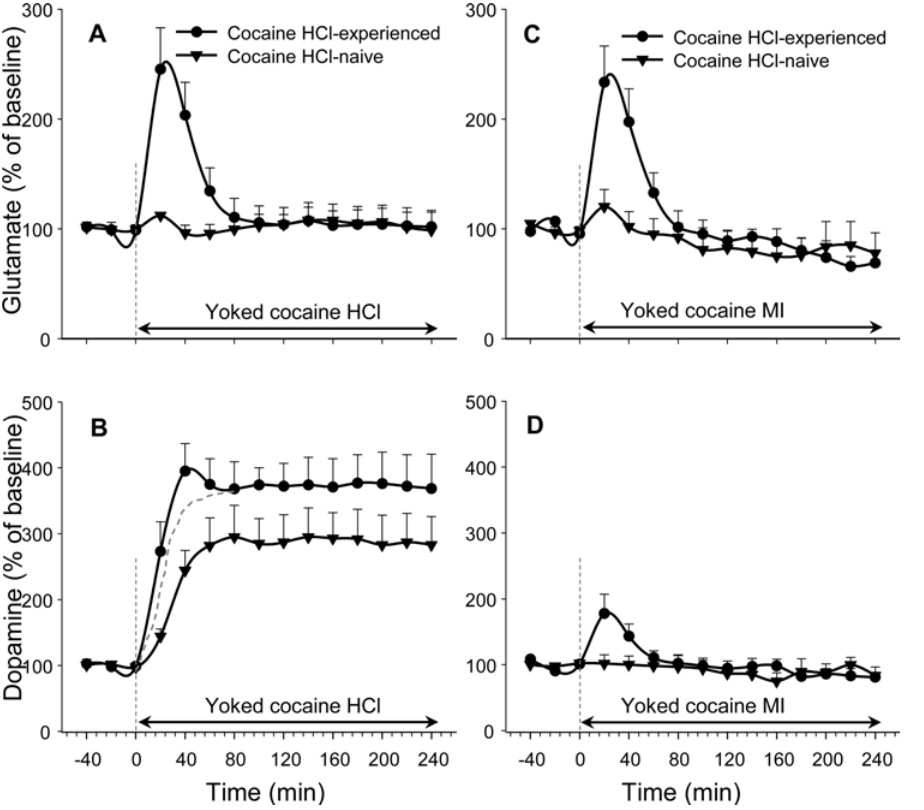
Figure 2. Mean glutamate top panels) and dopamine (bottom panels) fluctuations during yoked injections of cocaine HCl (left panels) or cocaine MI (right panels) in cocaine-naı¨ve animals or animals experienced with cocaine HCl. The dotted line in B represents the effects in cocaine-experienced animals of the peripheral-plus-central actions of cocaine HCl (circles in B) minus the peripheral-only action of cocaine MI (circles in D). The difference between this line and the line reflecting the effects of cocaine HCl in cocaine-naı¨ve animals (triangles in B) is the consequence of sensitization to cocaine in the cocaine-trained animals [40].